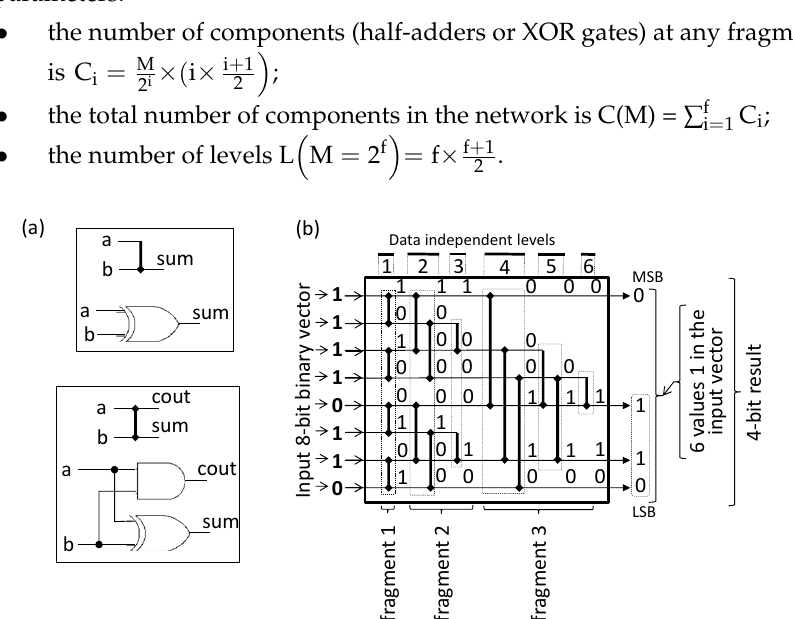
Figure 3. Basic components of a counting network ( a ); example of a counting network calculating the Hamming weight of an 8-bit binary vector ( b ).